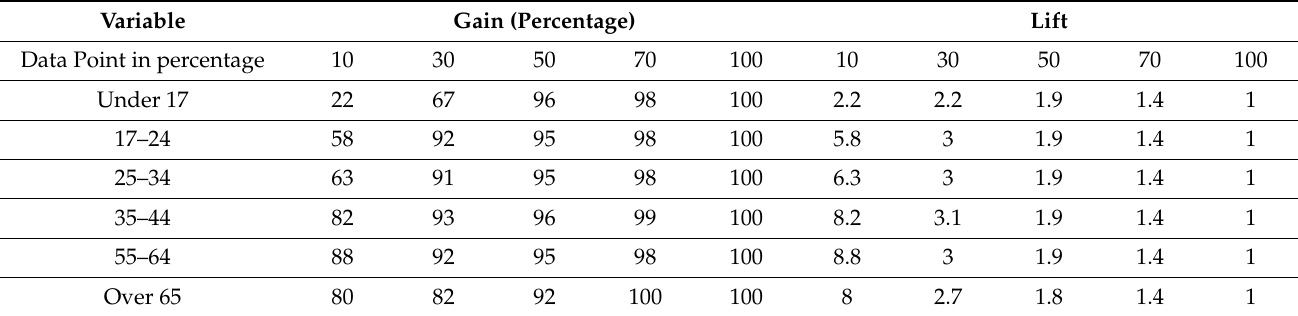
Table 4. The gain and lift values for output variables.